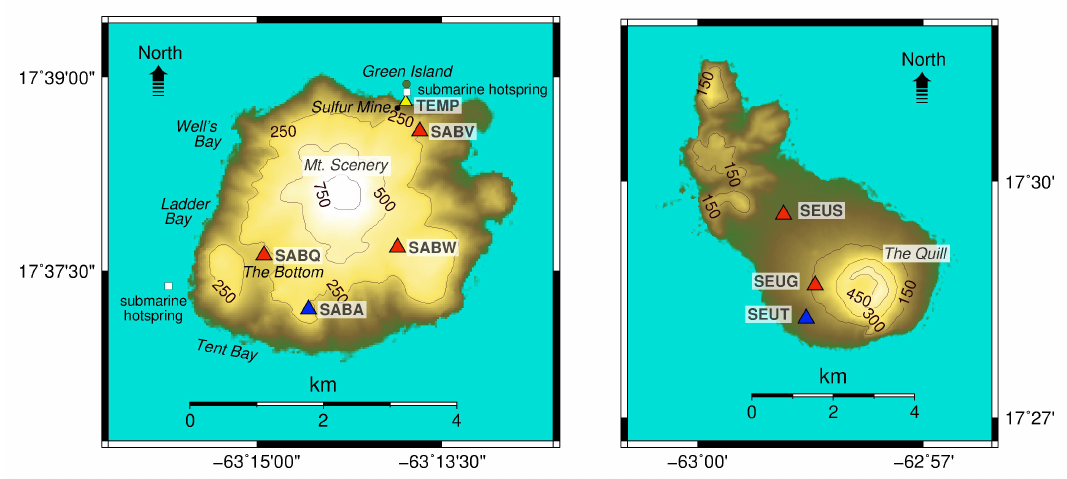
Figure 2. Geophysical monitoring network of the Royal Netherlands Meteorological Institute (KNMI) at Saba ( left ) and St. Eustatius ( right ): permanent sites with colocated seismometer and GNSS sensor (blue triangle), seismometer sites (red triangles), submarine hotsprings (white squares), and a temporary site with two temperature sensors (yellow triangle). SRTM Digital Elevation Model in the background with elevation contours in